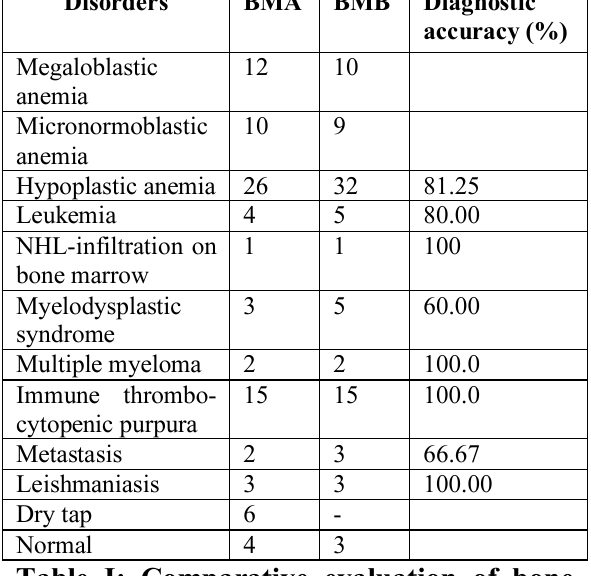
Table I: Comparative evaluation of bone